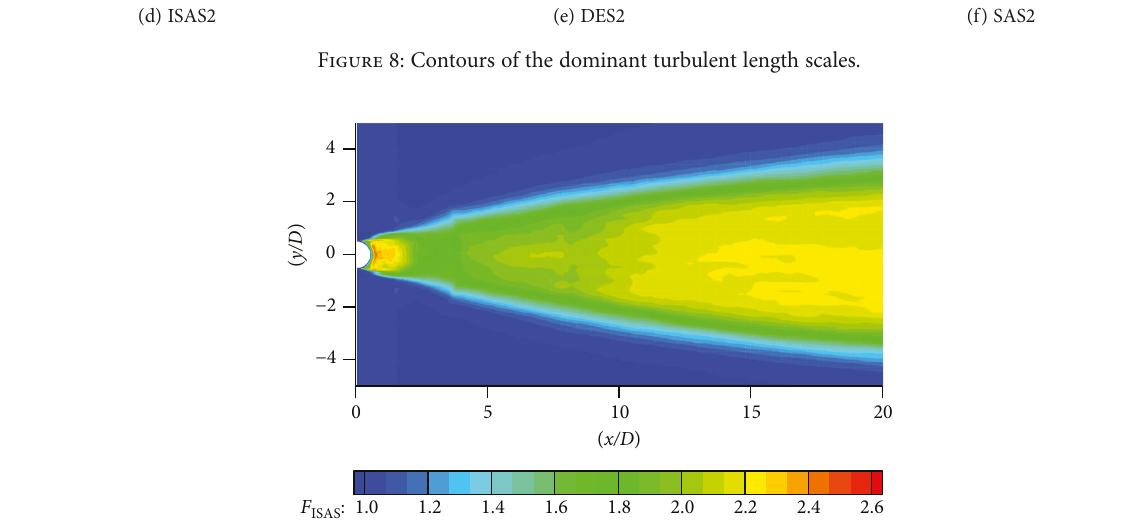
Figure 9: Time-averaged contours of the dominant turbulent length scales